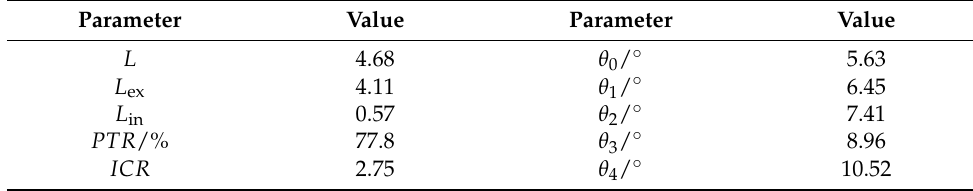
Table 1. Geometric parameters of the benchmark inlet.